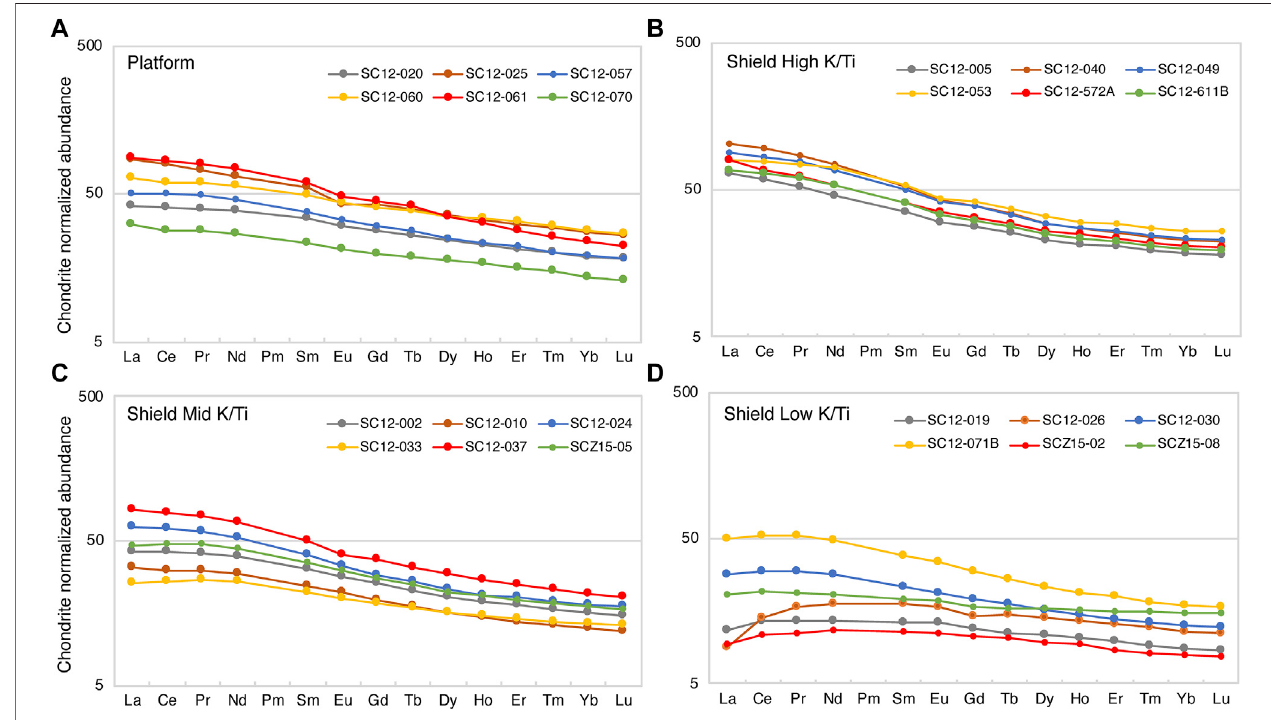
FIGURE5 | Representative chondrite-normalized rare earth element(REE) values. Normalizing valuesare from McDonough and Sun (1995). All symbols arelarger than 1 σ analytical error. (A) Platform Series. (B) High K 2 O/TiO 2 Shield Series. (C) Mid K 2 O/TiO 2 Shield Series. (D) Low K 2 O/TiO 2 Shield Series.